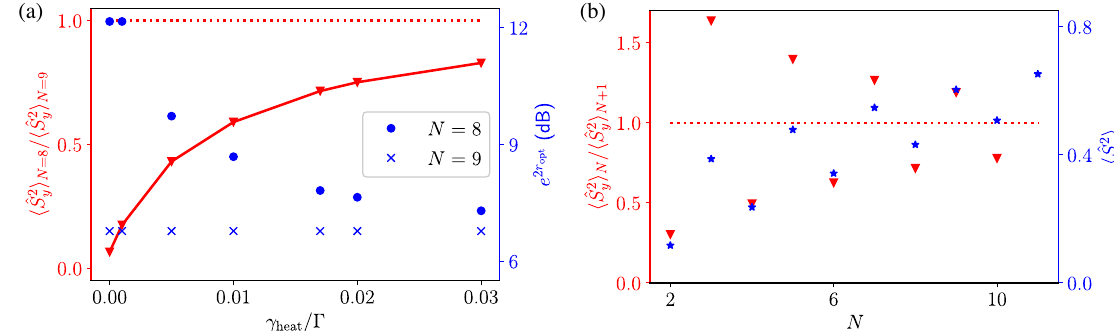
FIG. 10. Impact of an impure squeezed reservoir on the even-odd effect. For the trapped-ion setup introduced in Sec. VII A, motional heating at a rate γ is the dominant source of imperfections, which can be modeled by Eq. (29) using an effective squeezing parameter heat ˜ r and an effective temperature n introduced in Eqs. (32) and (33). (a) Ratio between h th heating rate γ (red triangles). The dotted red line is a guide to the eye to highlight a ratio of unity, i.e., no even-odd effect. For each heat , we optimize the squeezing parameter over the range 0 ≤ e 2 r ≤ 12 dB to minimize the variance h value of N and γ heat ˆ S 2 points). (b) Ratio of h for N vs N þ 1 spins as a function of N for an experimentally realistic parameter of γ y i triangles). Again, the dotted red line is a guide to the eye to highlight a ratio of unity, i.e., no even-odd effect. For each N , we optimize the squeezing parameter over the same range 0 ≤ e 2 r ≤ 12 dB as in (a) to minimize the variance h